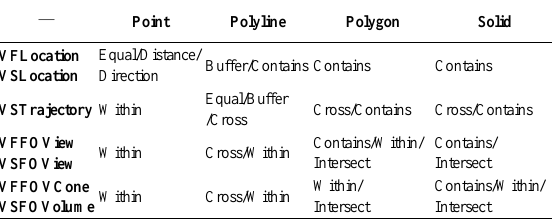
Table 1 Video query methods based on spatial